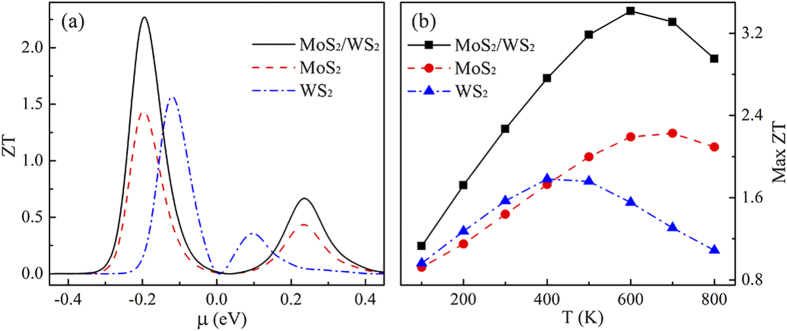
(a) ZT as a function of chemical potential  for MoS2/WS2 (N = 1), MoS2, and WS2 nanoribbons, respectively, at T = 300 K. (b) The Max ZT value as a function of temperature for MoS2/WS2 (N = 1), MoS2, and WS2 nanoribbons.